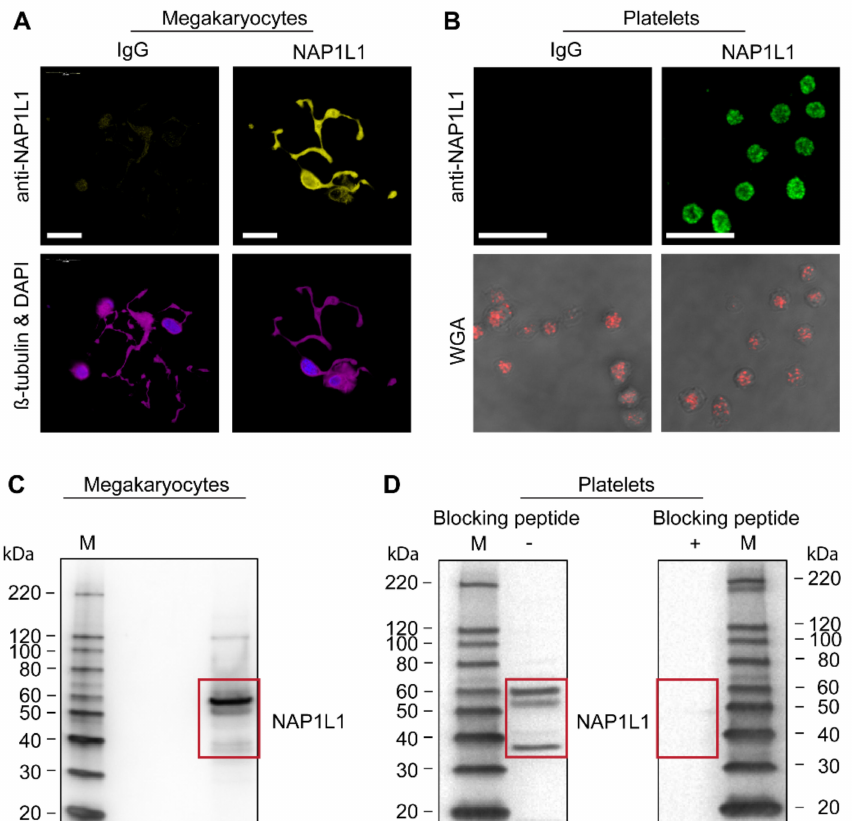
Figure 3. MKs and human PLTs express NAP1L1 protein. ( A ) CD34 + -derived MKs were placed on immobilized fibrinogen to induce proplatelet formation, fixed, and then incubated with an antibody against NAP1L1 (yellow, top right panel) or an IgG control, followed by co-staining for b-tubulin (magenta) and nuclei (40,6-diamidino-2-phenylindole, DAPI, blue), as shown in the bottom panels. Scale bars = 20 µ m. This figure is representative of n = 7 independent experiments. ( B ) NAP1L1 protein expression (green) in human PLTs. PLTs incubated with an IgG control antibody are shown (left, IgG). The bottom panels show the corresponding transmission images overlayed with the co-staining with WGA (red). Scale bars = 10 µ m. This figure is representative of n = 6 independent experiments. ( C ) Immunoblot analysis of MK lysates (day 13 of culture) using the anti-NAP1L1 antibody. The cells were lysed, and proteins separated by SDS-PAGE electrophoresis. NAP1L1 isoforms are highlighted by a red box. ( D ) Immunoblot analysis of PLT lysates using the anti-NAP1L1 antibody. The cells were lysed, and proteins separated by SDS-PAGE electrophoresis; however, the samples were split and processed in parallel in the absence ( left ) or presence ( right ) of an NAP1L1- quenching peptide. The presence of the blocking peptide prevents the detection of NAP1L1 with the anti-NAP1L1 antibody, demonstrating specificity for the three main NAP1L1 protein isoforms. Lanes labeled with M indicate the marker lane. ( C , D ), representative of 3 and 8 independent experiments,